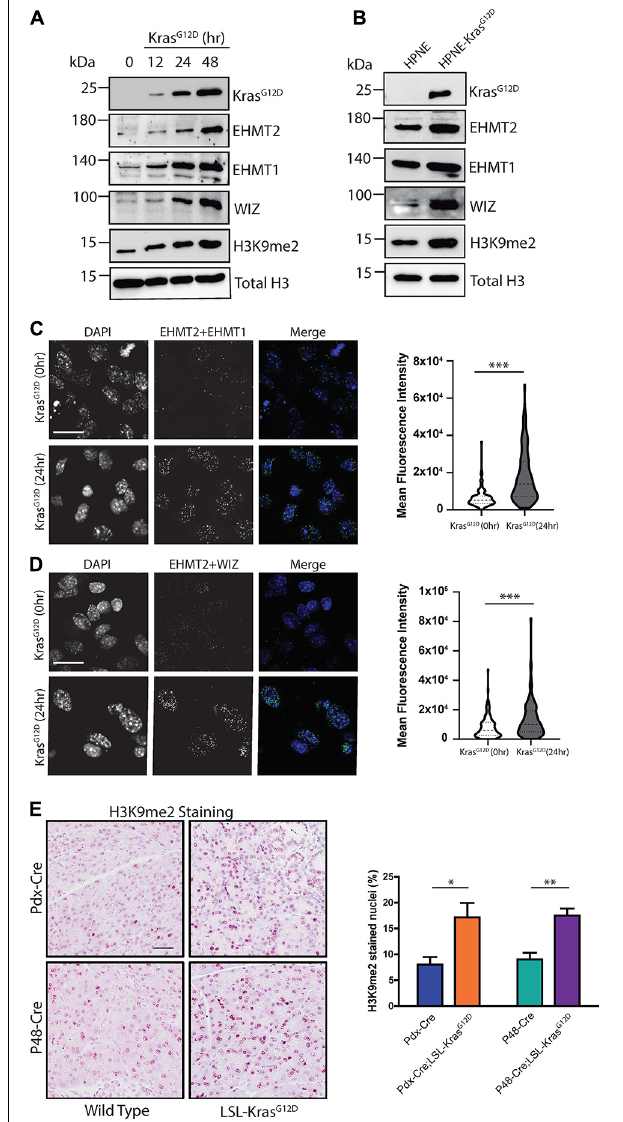
FIGURE 4 | Kras G 12 D promotes EHMT2-EHMT1-WIZ complex formation and H3K9me2 deposition. (A) Western blot evaluation of iKras 4292 cells after expression of Kras G 12 D . Kras G 12 D expression was stimulated with doxycycline for 12, 24, and 48 h, then members of the EHMT2 complex, including EHMT2, EHMT1, and WIZ, as well as its product, H3K9me2, were evaluated. Induction of Kras G 12 D was verified, and total H3 was used as loading control. Quantification is represented in Supplementary Figure 3A (experiment performed in triplicate). (B) Expression of KRAS G 12 D , EHMT2, EHMT1, WIZ, and H3K9me2 was evaluated by western blot in HPNE and HPNE-KRAS G 12 D cells, developed from human pancreatic ducts. Kras G 12 D expression is shown to be specific to HPNE-KRAS G 12 D cells. Total H3 was used as loading control. Quantification is represented in Supplementary Figure 3F (experiment performed in triplicate). (C) Interaction between EHMT2 and EHMT1 was evaluated using PLA. Left: Representative pictures of iKras 4292 cells at 0 and 24 h after Kras G 12 D activation. Scale = 50 µ M. Right: Violin plot representing Mean Fluorescence Intensity (MFI) of EHMT2/EHMT1 positive PLA signal (experiment performed in triplicate). (D) Interaction between EHMT2 and WIZ was also evaluated using PLA. Left: